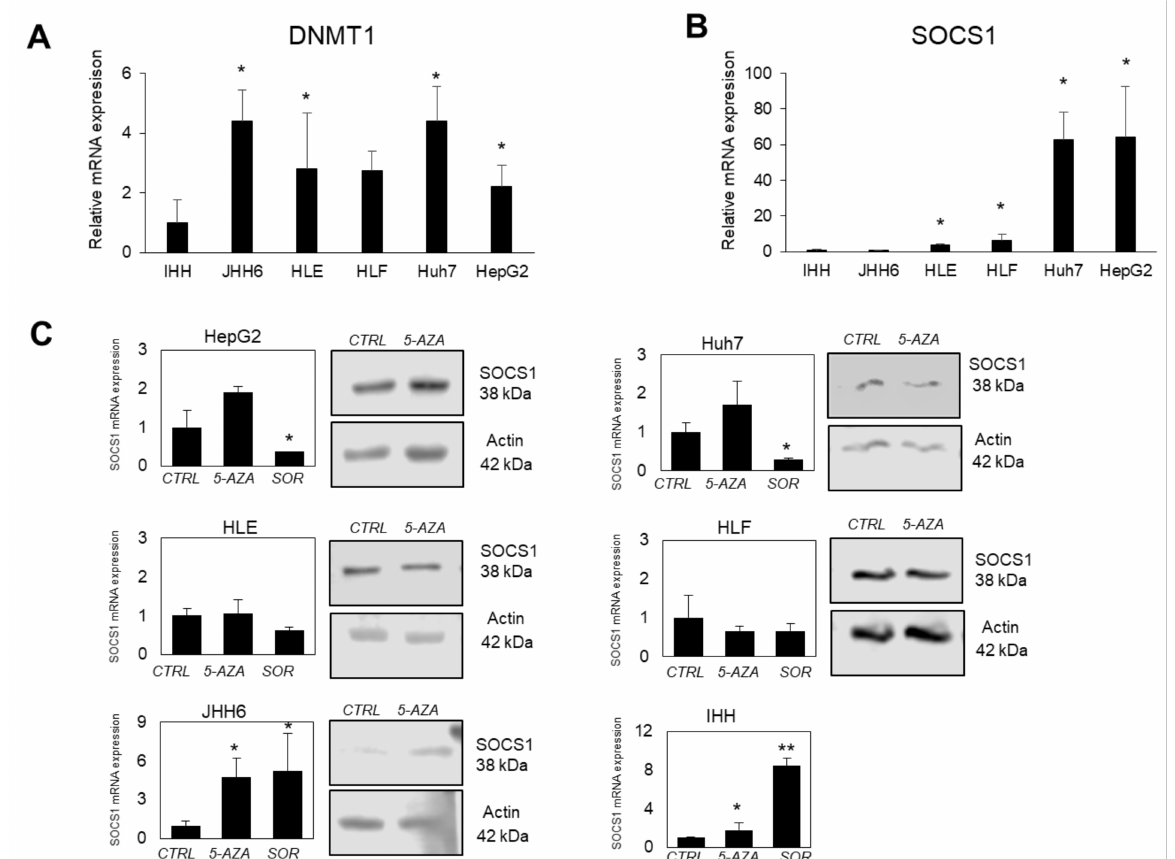
Figure 3. The effect of 5-Azacytidine (5-AZA) in SOCS1 expression in in vitro models. ( A ) Relative mRNA expression of DNMT1 in HCC cell lines JHH6, HLE, HLF, Huh7, and HepG2 compared to non-tumoral IHH cells (=1.0). Statistical analysis: * p < 0.05 using Student’s t-test relative to IHH. ( B ) Relative mRNA expression of SOCS1 in HCC cell lines compared to non-tumoral IHH cells (=1.0). Statistical analysis: * p < 0.05 using Student’s t-test relative to IHH. ( C ) mRNA expression and representative protein blot of SOCS1 (38 kDa) in hepatic cell lines after 24 h treatment of 5 uM of 5-AZA and 50 uM of sorafenib. Actin (42 kDa) was used as housekeeping in protein blot. Statistical analysis: * p < 0.05, ** p < 0.01 Student’s t-test relative to CTRL for each cell